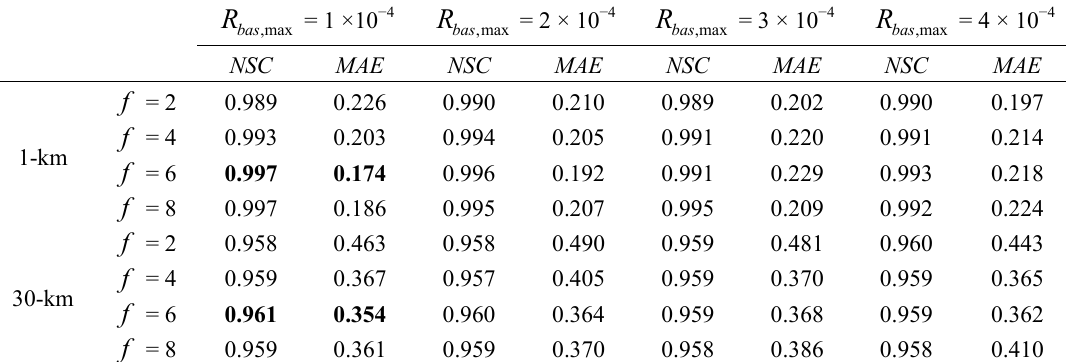
Table 2. Comparison of the CoLM performance at 1-km and 30-km resolutions for total runoff by the Nash-Sutcliffe coefficient NSC and the mean absolute error MAE with the decay factor f (in·m − 1 ) and the maximum baseflow coefficient R for the study basin in